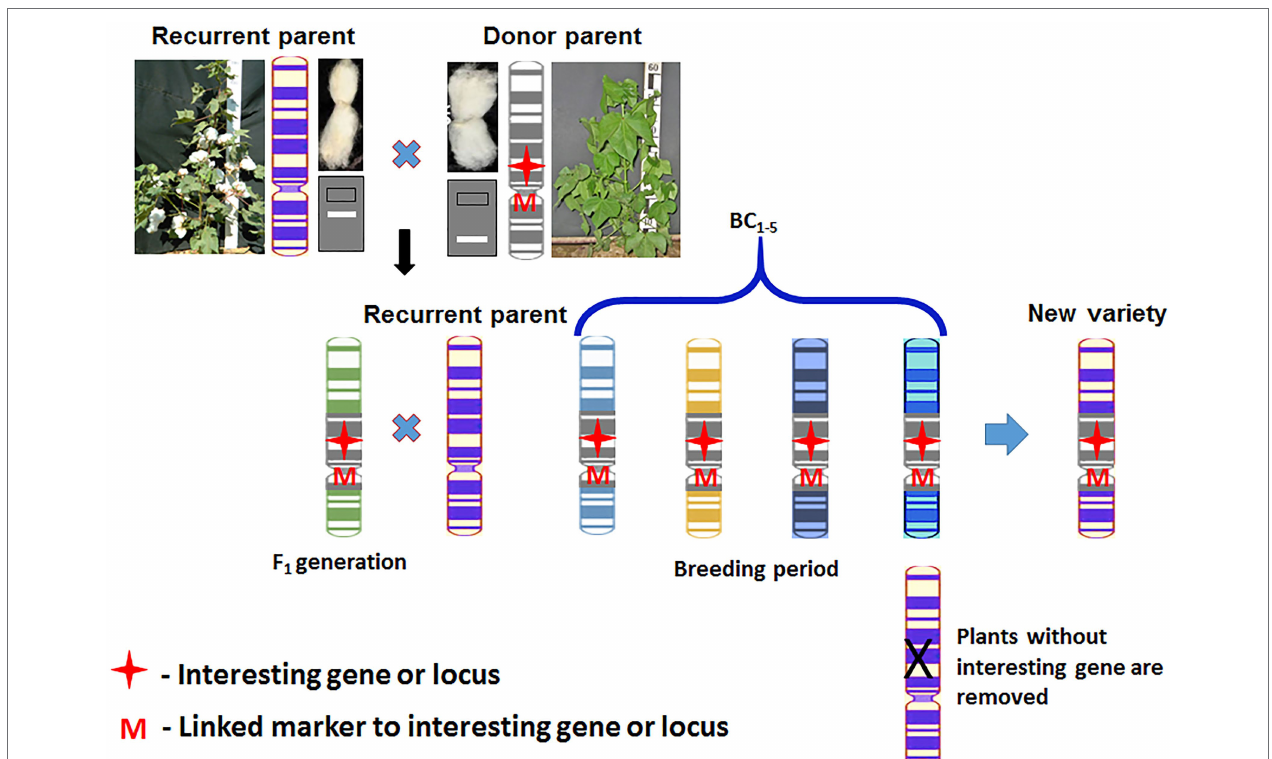
FIGURE 4 | The scheme of marker-assisted backcross